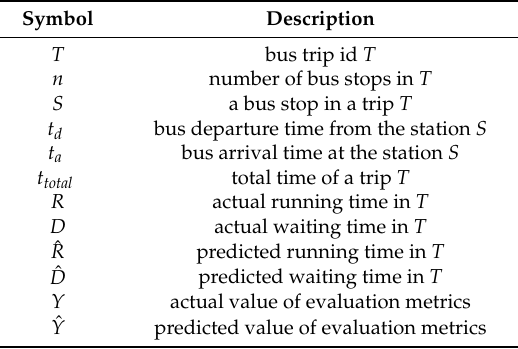
Table 1. List of important